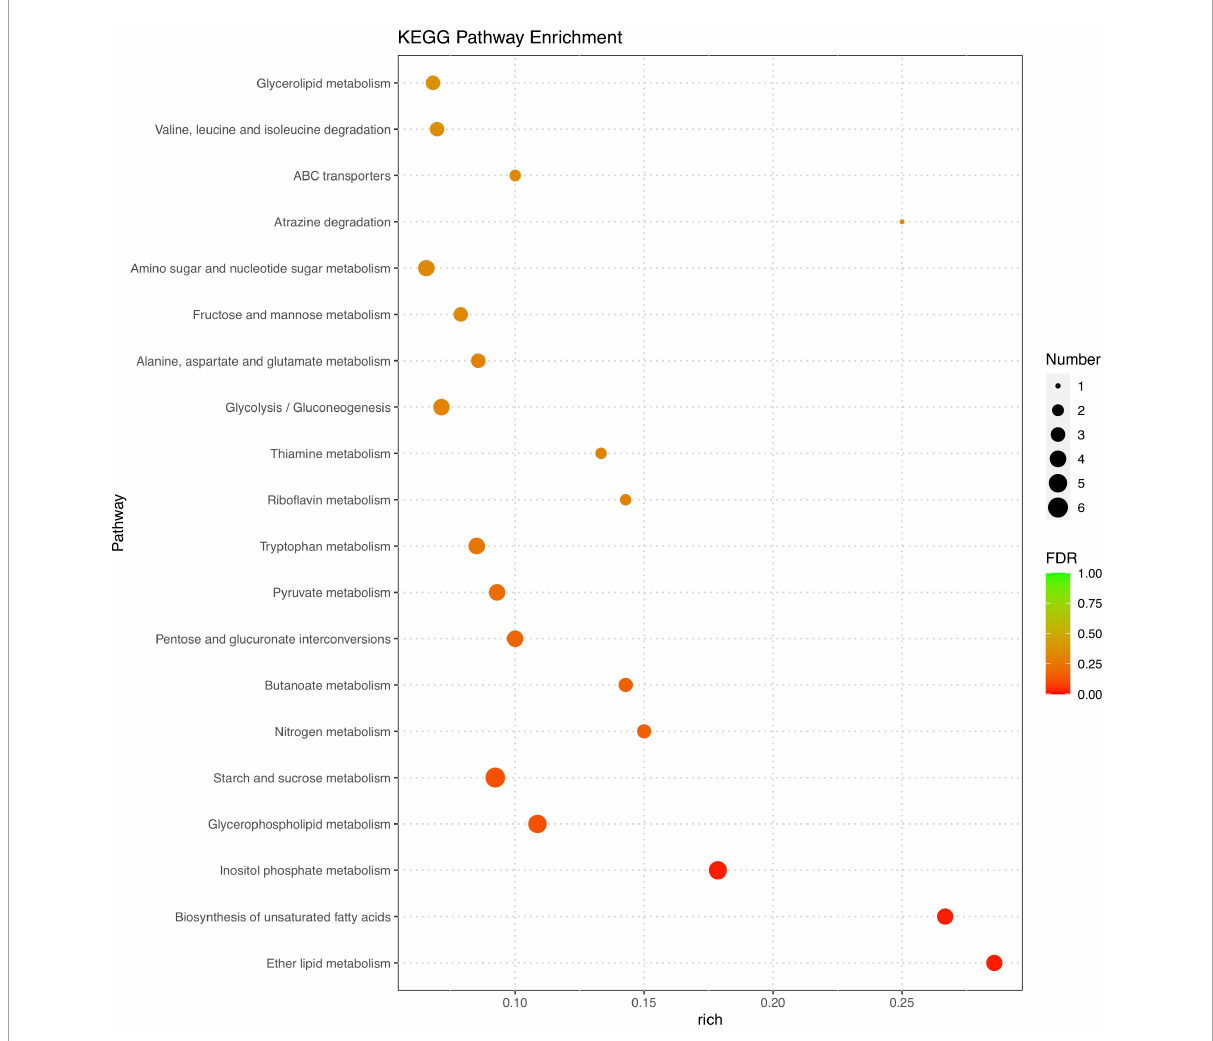
FIGURE6 Kyoto encyclopedia of genes and genomes (KEGG) pathway functional annotation of differentially expressed genes (fold change > 1) between Penicillium olsonii WHG5 (control; WHG5 cultured without Bacillus velezensis metabolites) and WHG5_FL (treatment; WHG5 cultured with B. velezensis